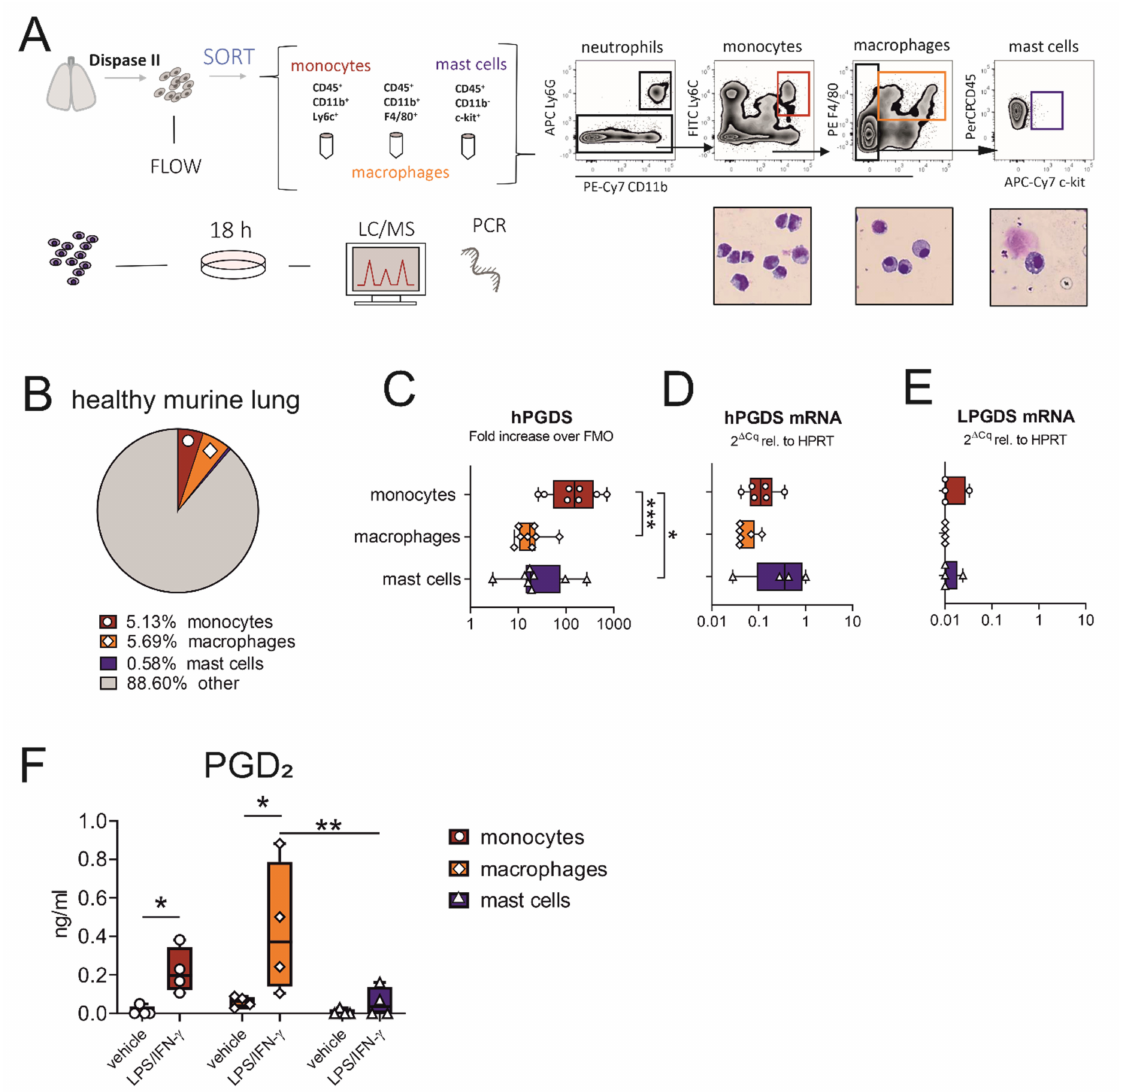
Figure 2. Macrophages and monocytes sorted from the healthy murine lung express hPGDS, but not LPGDS, and release PGD 2 upon stimulation with LPS/IFN- γ . ( A ) Schematic experimental approach. Total lung was extracted and digested with Dispase II. Monocytes, macrophages and mast cells were sorted from whole lung single-cell suspension according to displayed gating strategy. Representative images of populations obtained after sorting were stained with Diff/Quik (pooled from 2 mice, n = 4). ( B ) Mean percentage of monocytes, macrophages and mast cells of total viable cells obtained from healthy lungs. ( C ) Flow cytometry showed that lung-associated monocytes express high levels of hPGDS. ( D ) hPGDS transcriptional expression was comparable in all three sorted populations, while ( E ) LPGDS mRNA was very low. ( F ) Stimulation with LPS/IFN- γ for 18 h significantly increased PGD 2 levels in monocyte- and macrophage-conditioned media. Data are shown as box-and-whisker plots with one data point representing one mouse, n = 4–8, ( C – E ) one-way ANOVA for repeated measurements with Tukey’s post hoc test (log-transformed) or ( F ) two-way ANOVA for repeated measurements with Fisher’s LSD post hoc test, * p < 0.05, ** p < 0.01, *** p <